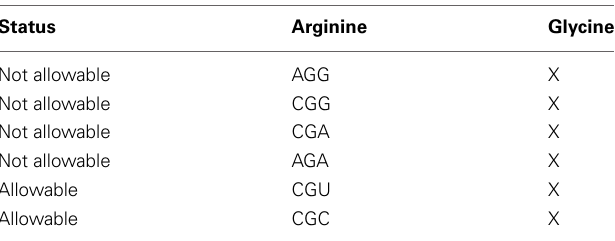
Table 2B | N/A Affinity >